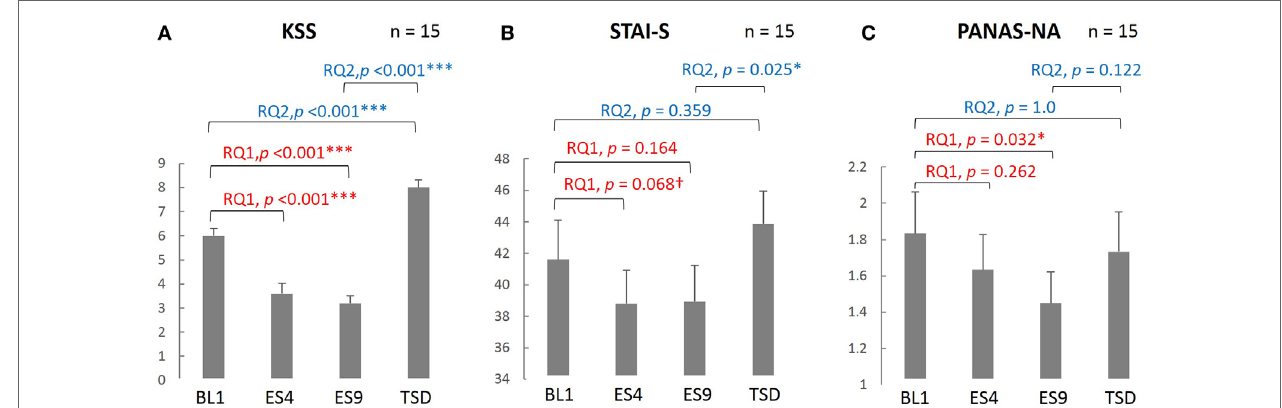
FigUre 2 | Comparison of the subjective sleepiness and mood state scores among different sleep conditions. KSS (a) , PANAS-NA (B) , and STAI-S (c) were analyzed based on the following two research questions (RQs): (RQ1) Comparison between BL1 and ES9 to investigate the effect of extended sleep ( t test for KSS and STAI-S and Wilcoxon signed-rank test for PANAS-NA); (RQ2) Comparison between BL1 and TSD to determine whether the TSD would erase the effect of sleep extension and whether the subjective indices after TSD would be comparable to those at the baseline level. *** p < 0.001, * p < 0.05, † p < 0.1; p values were adjusted for multiple comparison. RQ, research question; KSS, Karolinska Sleepiness Scale; PANAS-NA, Positive And Negative Affect Schedule, Negative Affect; STAI-S, State-Trait Anxiety Inventory-State Anxiety scale; BL1, baseline Day 1; ES4, extended sleep Day 4; ES9, extended sleep Day 9; TSD, total sleep